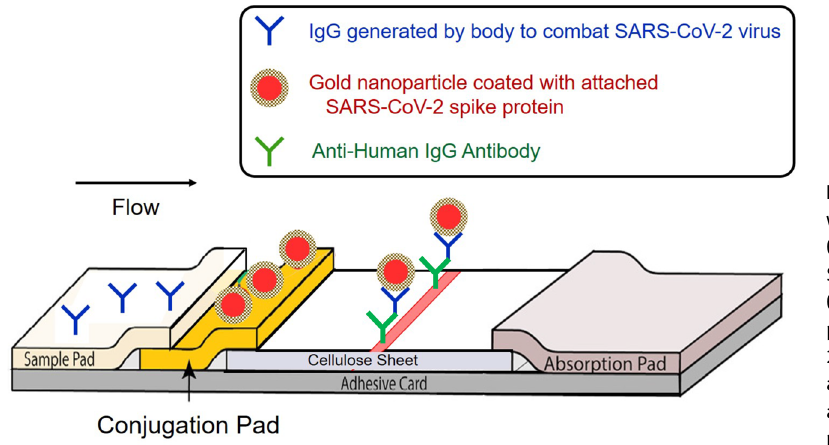
Figure 8: Schematic illustration for the wicking membrane with gold nanoparticle (NP) coated with Severe Acute Respiratory Syndrome-Corona Virus-2 (SARS-CoV-2) (see Table A1) spike protein. When the patient ’ s blood with Corona Virus Disease- 2019(COVID-19)IgG(seeTableA1)is fl owed, assemblages of IgG and gold NP will be produce fl